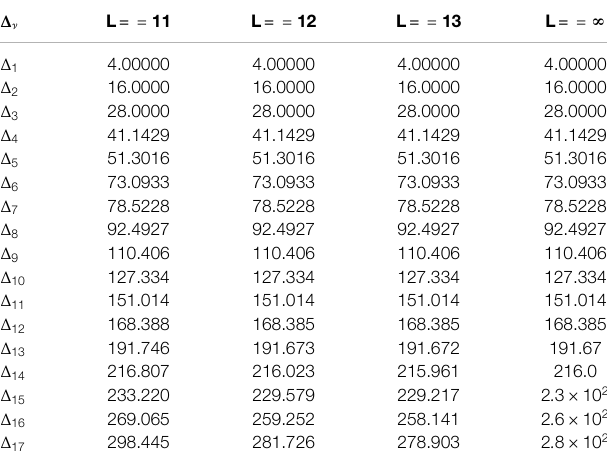
TABLE 1| Recurrants forthetransverseANNNImodel, with B (cid:2) 1 . 0, J 2 (cid:2) 1 . 0and several chain sizes. The rightmost column is the extrapolation for the thermodynamic limit ( L (cid:2) ∞ ).